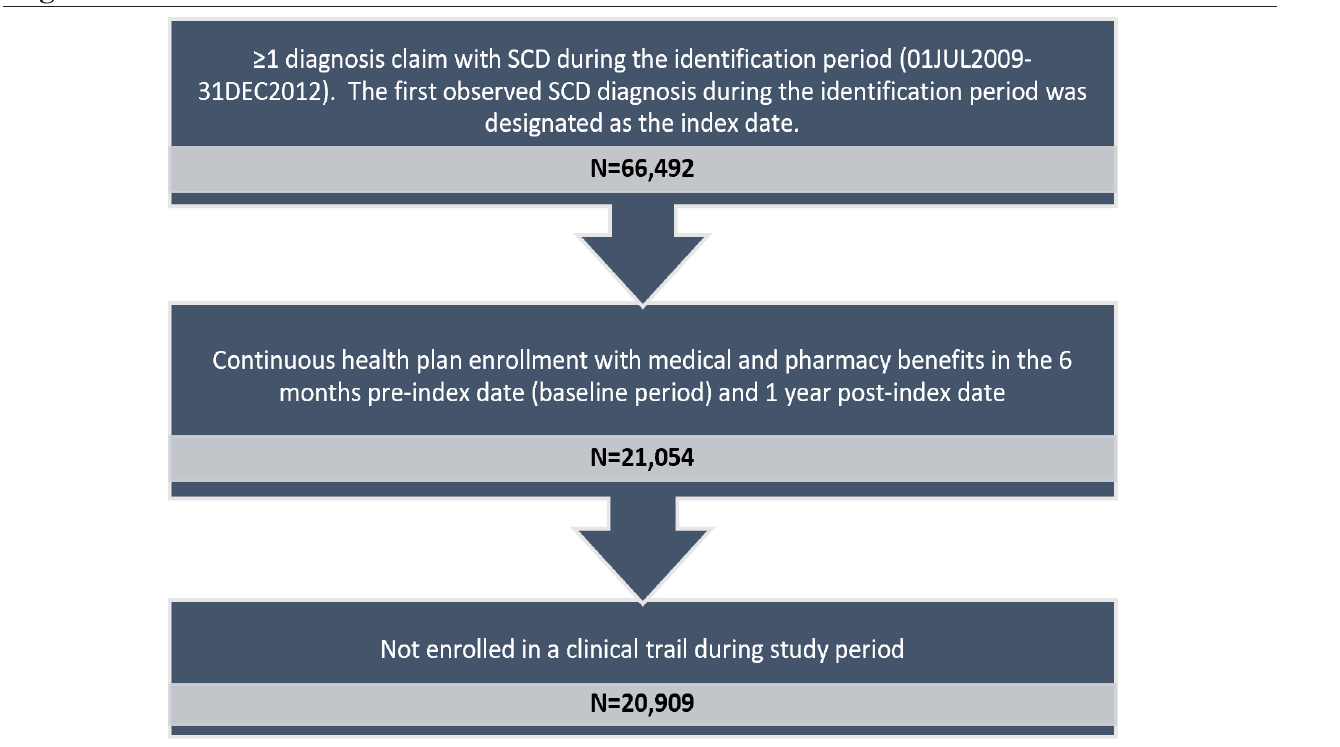
Figure 1. Patient Selection Flow